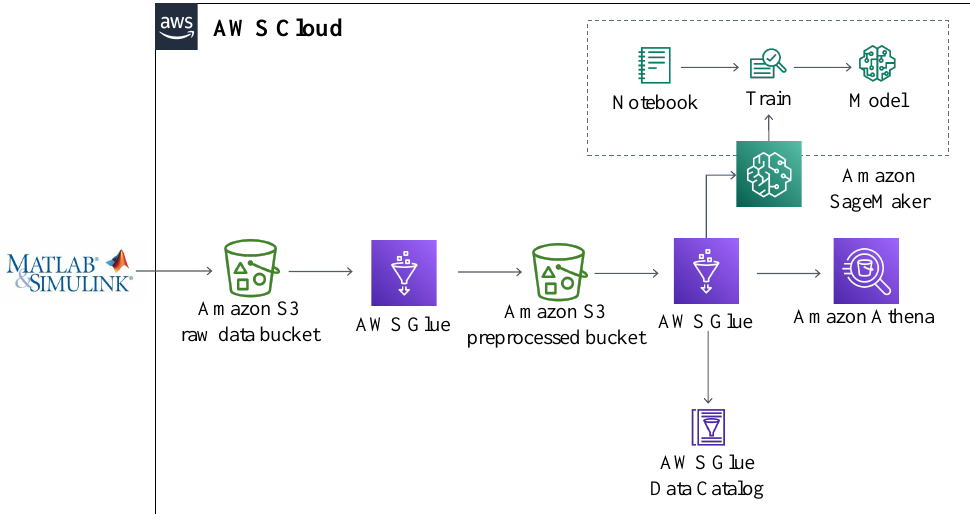
Figure 11. Data pipeline for the ML-based FDD strategy developed in Amazon Web